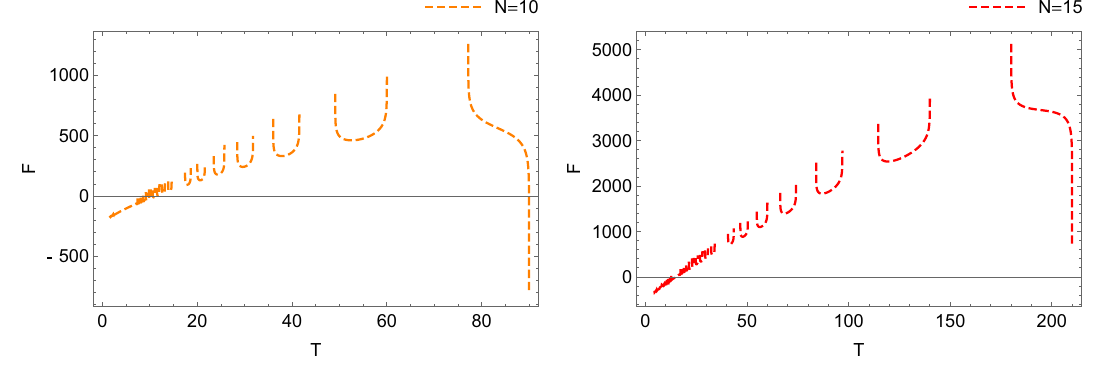
Fig. 4 Helmholtz free energy in terms of temperature with G = m = k = 1, and λ = 1 /